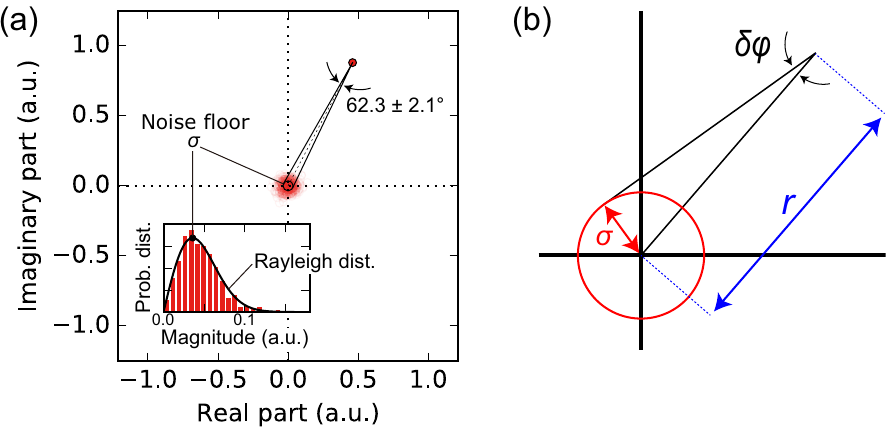
Figure 4. ( a ) Measured Fourier coefficient of the first peak plotted in an IQ diagram, with the inset representing a histogram of noise magnitudes and ( b ) definition of the phase precision as a projection angle of noise around the origin from a measured